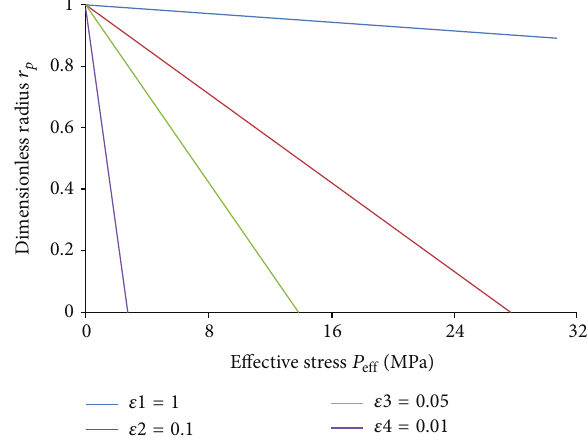
Figure 4: Effect of aspect ratio on oval pores.